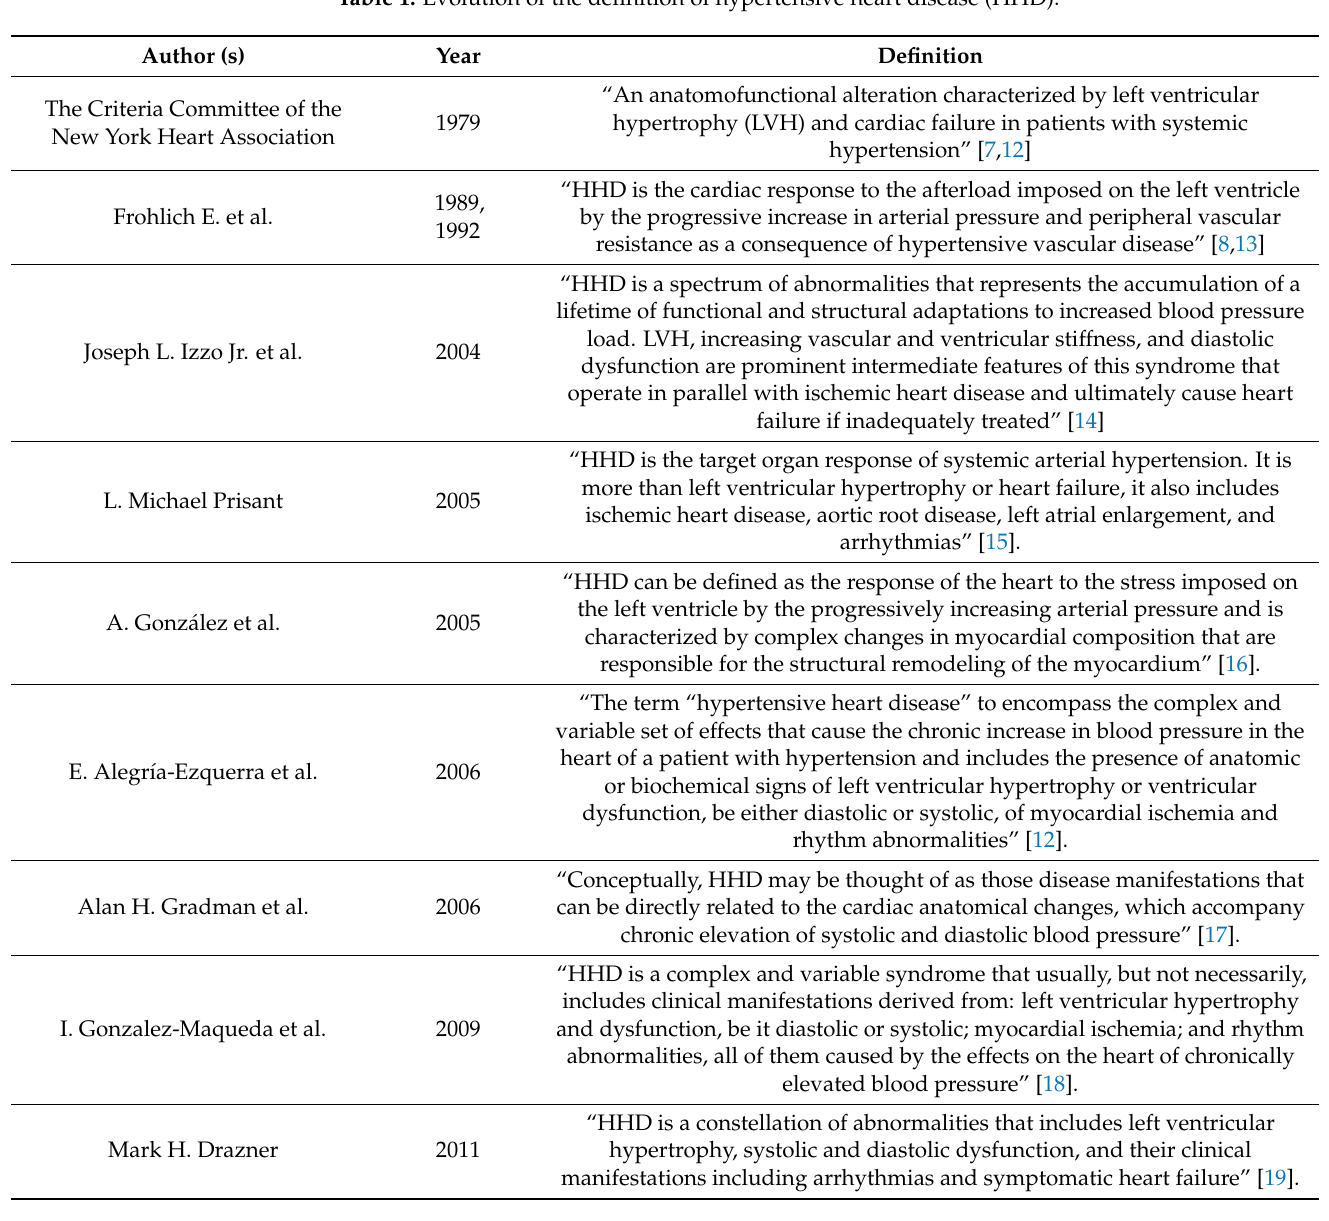
Table 1. Evolution of the definition of hypertensive heart disease